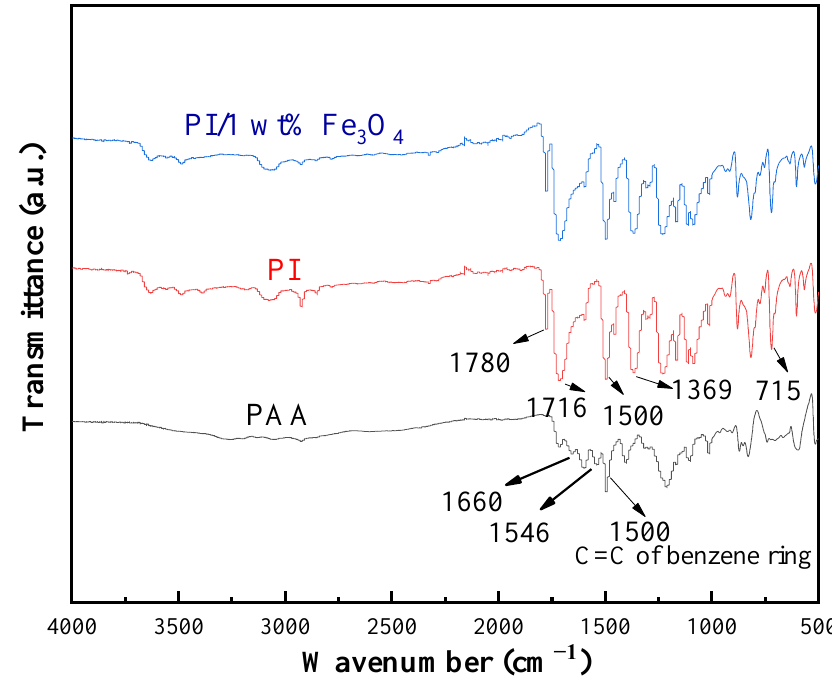
Figure 1. Fourier transform infrared spectra of PAA, PI, and Fe 3 O 4 /PI nanocomposite films.